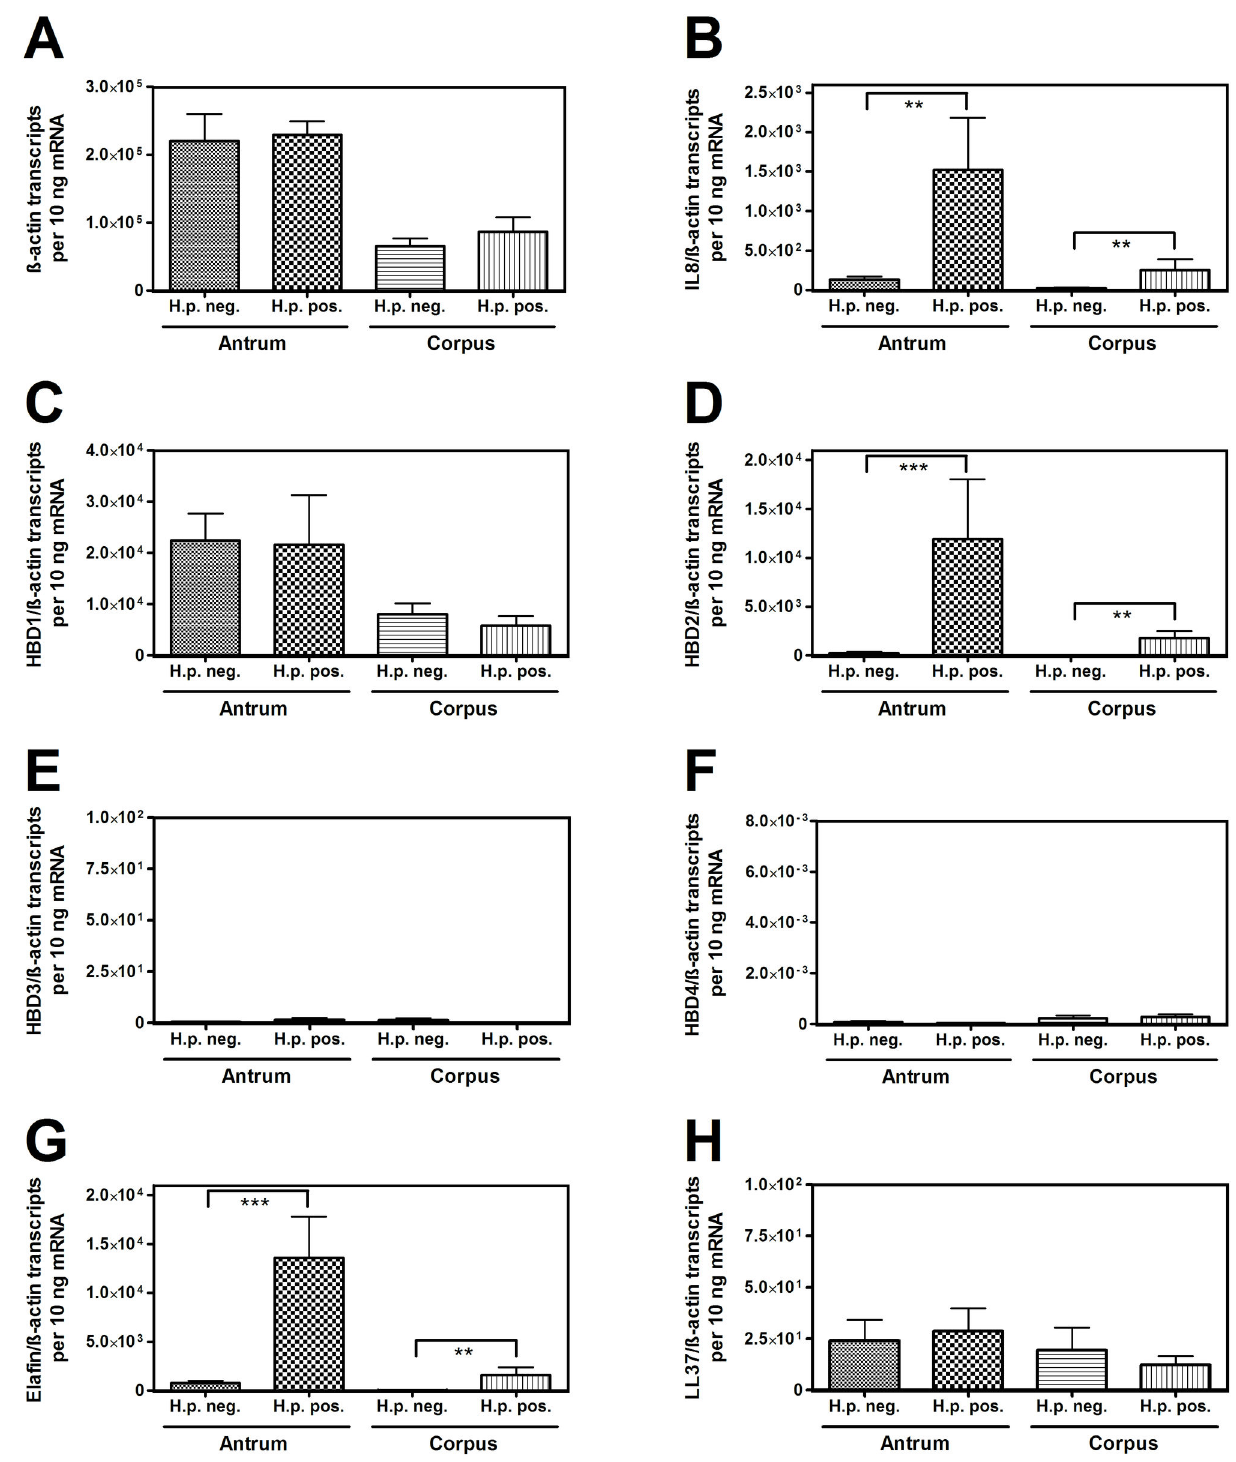
Figure 1. β-actin, IL8, HBD1-4, elafin and LL37 expression in relation to H. pylori . β-actin (A) expression is almost equal in H. pylori negative and positive antrum and corpus. IL8 (B) transcripts are comparably induced in H. pylori antrum and corpus gastritis. HBD1 (C) is constitutively expressed, whereas HBD2 (D) and elafin (G) are significantly enhanced in H. pylori populated tissue. HBD3 (E), HBD4 (F) and LL37 (H) mRNA was only marginally detected (**: p<0.01, ***: p<0.001).